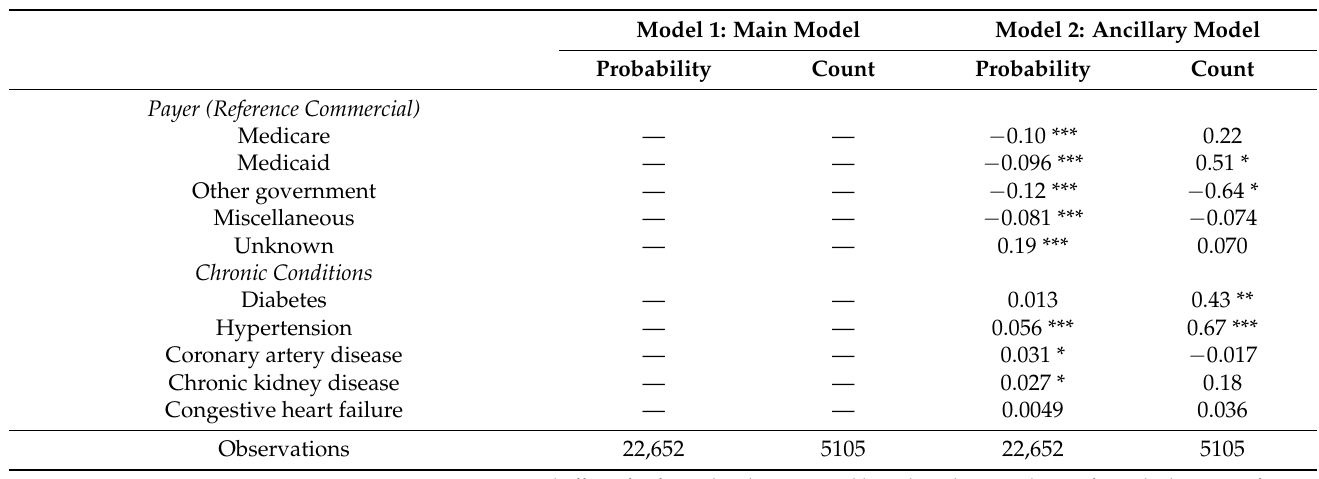
Table 3. Cont. Model 1: Main Model Model 2: Ancillary Model